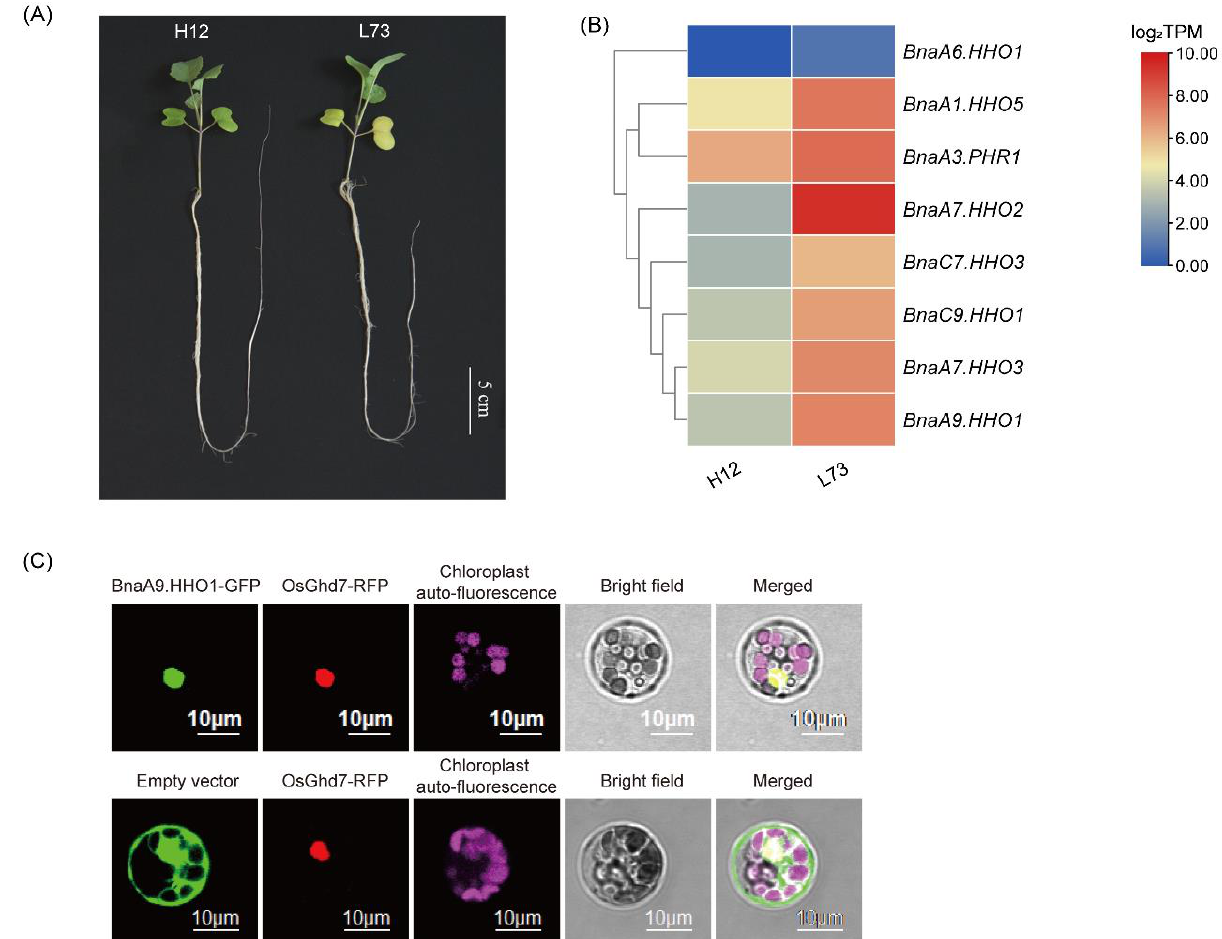
Figure 10. Characterization of the rapeseed genotypes H12 and L73 growing under nitrate (NO 3 − ) limitation conditions and subcellular localization analysis of BnaA9.HHO1 . ( A ) Growth performance of the high-NUE genotype H12 and the low-NUE genotype L73 growing under low (0.3 mM) NO 3 − condition. ( B ) Expression profiles of the BnaGARP DEGs between H12 and L73 under NO 3 − limitation conditions. ( C ) Subcellular localization analysis of BnaA9.HHO1 . OsGhd7 was used as a nuclear marker and fused with a red fluorescent protein sequence.